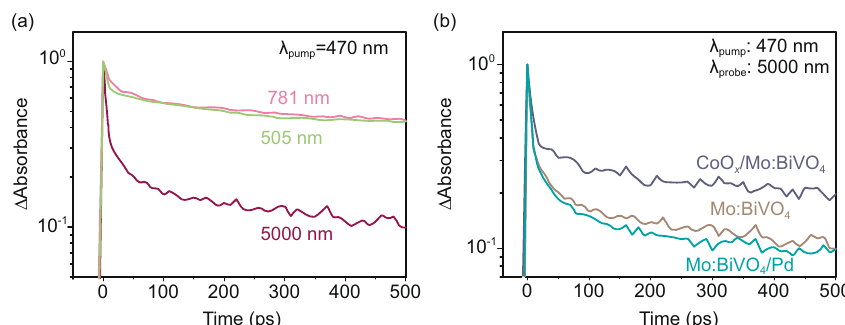
Fig. 3 Charge-carrier dynamics at picosecond time-scale. a Transient pro fi les of photocarriers probed at 505 nm (trapped holes), 781 nm (deeply trapped electrons), and 5000 nm (free/shallowly trapped electrons) in Mo:BiVO 4 . b Transient pro fi les of photocarriers probed at 5000 nm (free/shallowly trapped electrons) for Mo:BiVO 4 , CoO x /Mo:BiVO 4 and Mo:BiVO 4 /Pd. Pump wavelength: 470 nm (4 μ J pulse −